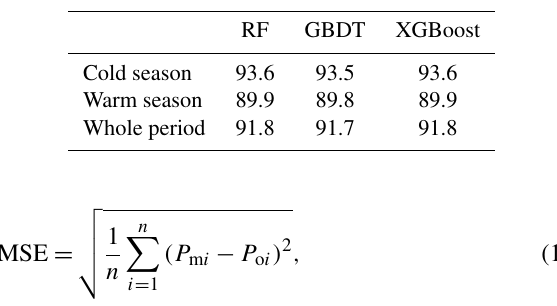
Table 2. The classification accuracy of wet/dry days during the warm season and cold